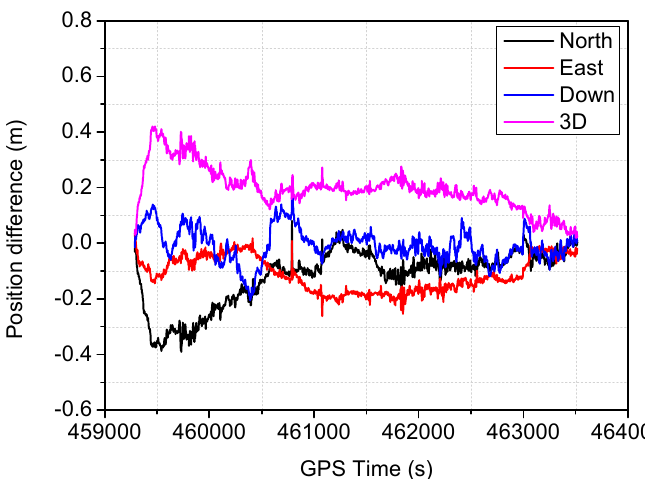
Figure 6. Position difference from the troposphere-constraint fixed PPP/INS.